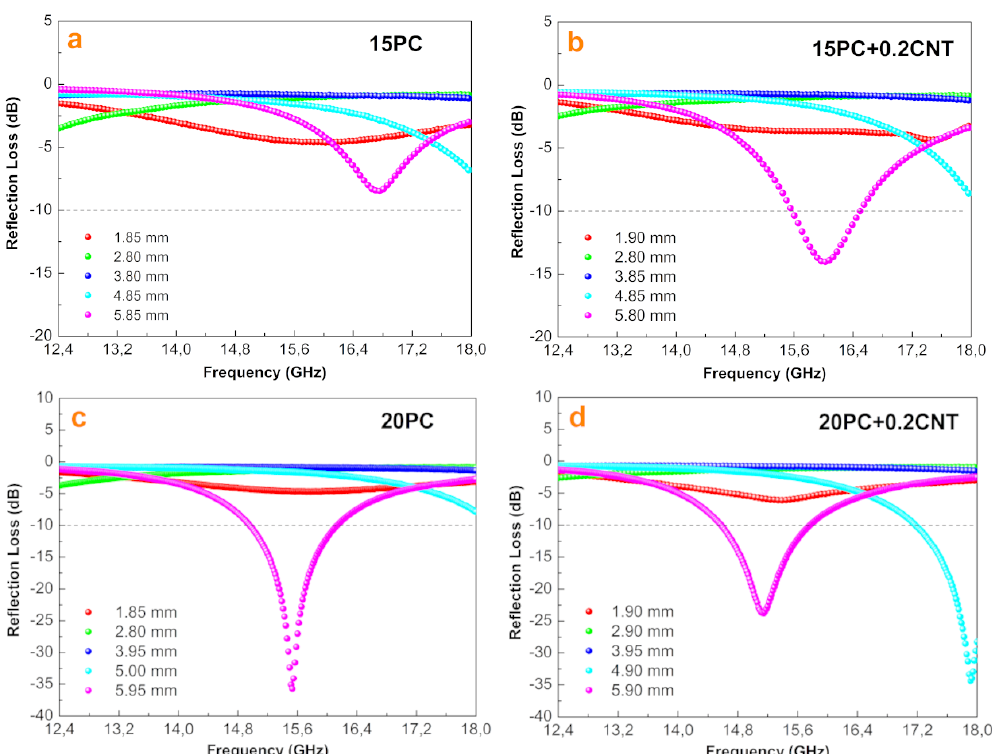
Figure 3. Reflection Loss: (a) 15PC; (b) 15PC+0.2CNT; (c) 20PC; (d)